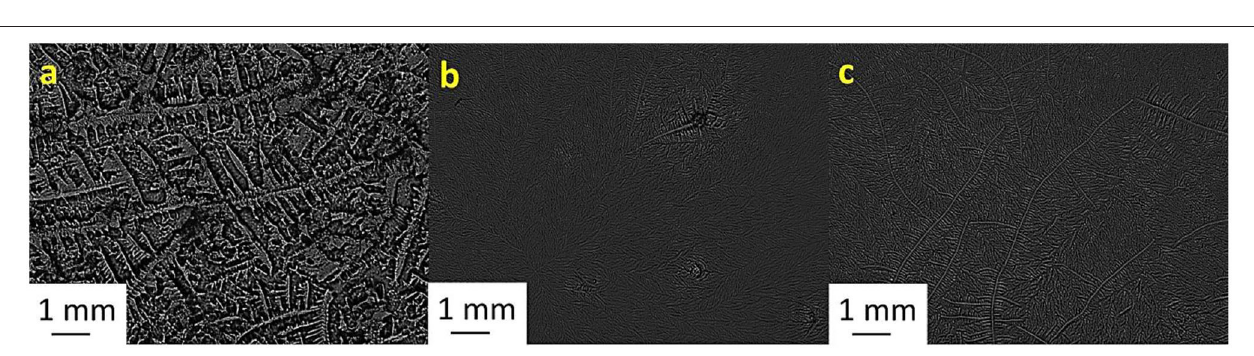
FIGURE 5 | Tear ferning patterns of (a) S5, (b) S5:MgCl 2 .6H 2 O (1:2), and (c) S5:NaH 2 PO 4 (1:10). S5, fifth sheep tear sample.